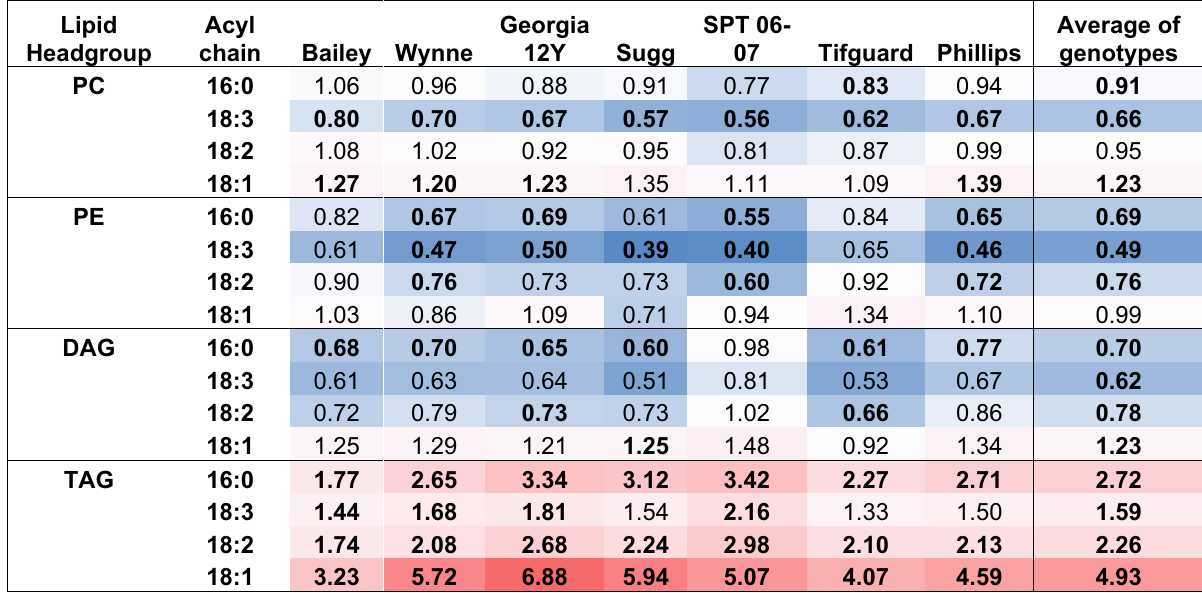
Table 1. Fold change of fatty acid for HT/AT in each lipid class. Lipid molecular species for which the fatty acyl composition is unambiguous were used in the analysis. For PC, this included 34:4 (16:1/18:3), 34:3 (16:0/18:3), 34:2 (16:0/18:1), 34:1 (16:0/18:1), 36:6 (18:3/18:3), 36:5 (18:2/18:3), and 36:1 (18:0/18:1). For PE, 34:3 (16:0/18:3), 34:2 (16:0/18:1), 34:1 (16:0/18:1), 36:6 (18:3/18:3), and 36:5 (18:2/18:3) were included. For DAG, all species were included, and for TAG, all species except TAG(54:5) were included. The fold values were calculated as the sum of (each molecular species times the number of occurrences of the fatty acid in that species) in HT/ the sum of (each molecular species times the number of occurrences of the fatty acid in that species) in AT. Lipid molecular species are identified as total acyl carbons: total double bonds. Bolded numbers represent significant changes from AT to HT (α = 0.05; Supplementary Table S3). Red shades represent increase and blue shades represents decrease in fold change. AT, ambient temperature (31/22 °C for 2018 and 28/22 °C for 2019; average day/night temperatures during the 17- d and 18-d treatment periods in 2018 and 2019, respectively); HT, high temperature (41/27 °C for 2018 and 38/26 °C for 2019). DAG, diacylglycerol; PC, phosphatidylcholine; PE, phosphatidylethanolamine; TAG,